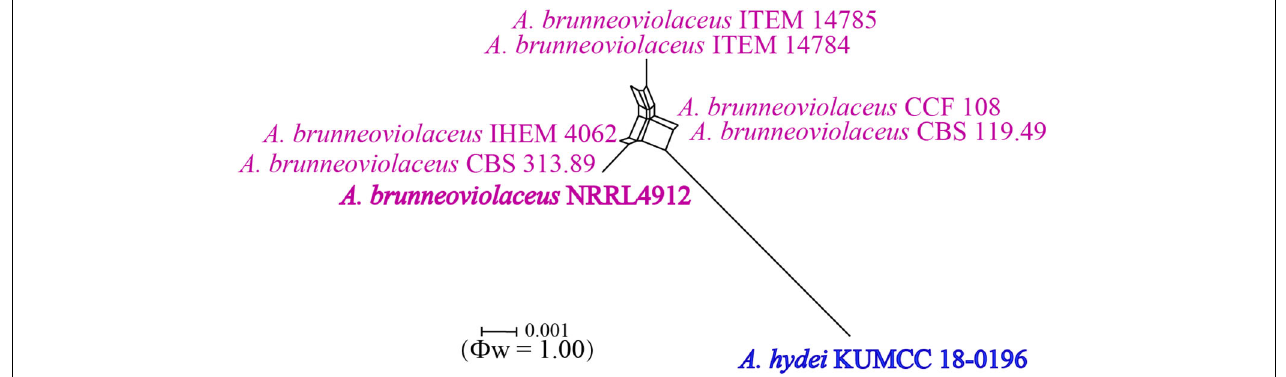
FIGURE 7 | Split graph showing the results of the pairwise homoplasy index (PHI) test of the combined CaM , BenA , ITS and RPB2 sequence data between Aspergillus brunneoviolaceus and A. hydei using LogDet transformation and splits decomposition. PHI test result ( (cid:56) w) < 0.05 indicates significant recombination within the dataset. Ex-type strains are indicated in